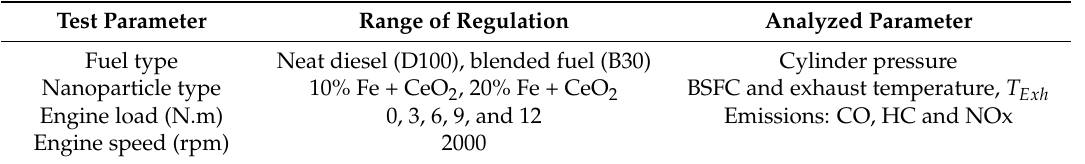
Table 3. Experimental test program.